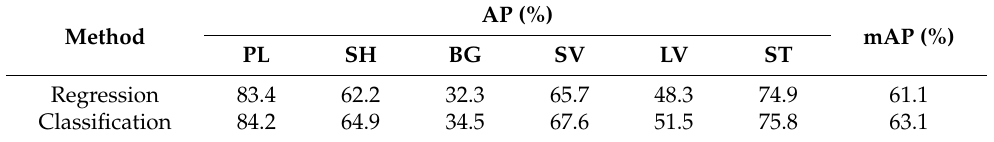
Figure 6. Visualization results of multi-scale feature maps. From top to bottom, there are the multi- ( i = 3,4,5,6,7 ) , the multi-scale feature maps CLS scale feature maps P (cid:48) i classification tasks, and the multi-scale feature map REG i ( i = 3,4,5,6,7 ) used for regression tasks. Table 3. Experimental results of RetinaNet using classification and regression methods to predict angles.